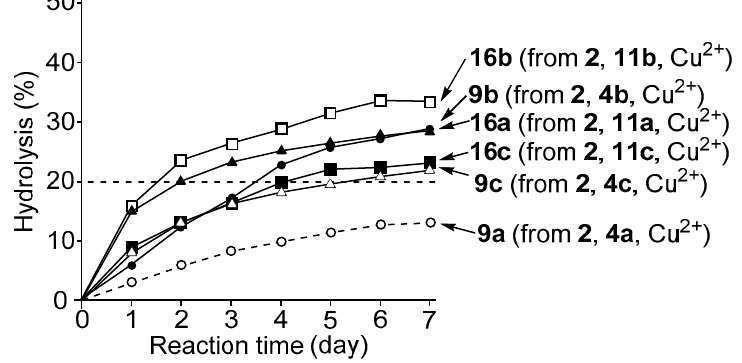
Figure 5. Hydrolysis of MNP (100 μ M in the total solution) by 9a (open circles), 9b (closed triangles), 9c (open triangles), 16a (closed circles), 16b (open squares), and 16c (closed squares) ([ 9 , 16 ] = 20 μ M in the total solution) in CHCl 3 /50 mM HEPES buffer (pH 7.4) with I = 0.1 (NaNO 3 ) (2/8) at 37 °C. The concentrations of the product (4-nitrophenol) were determined in the total two-phase solvent system.